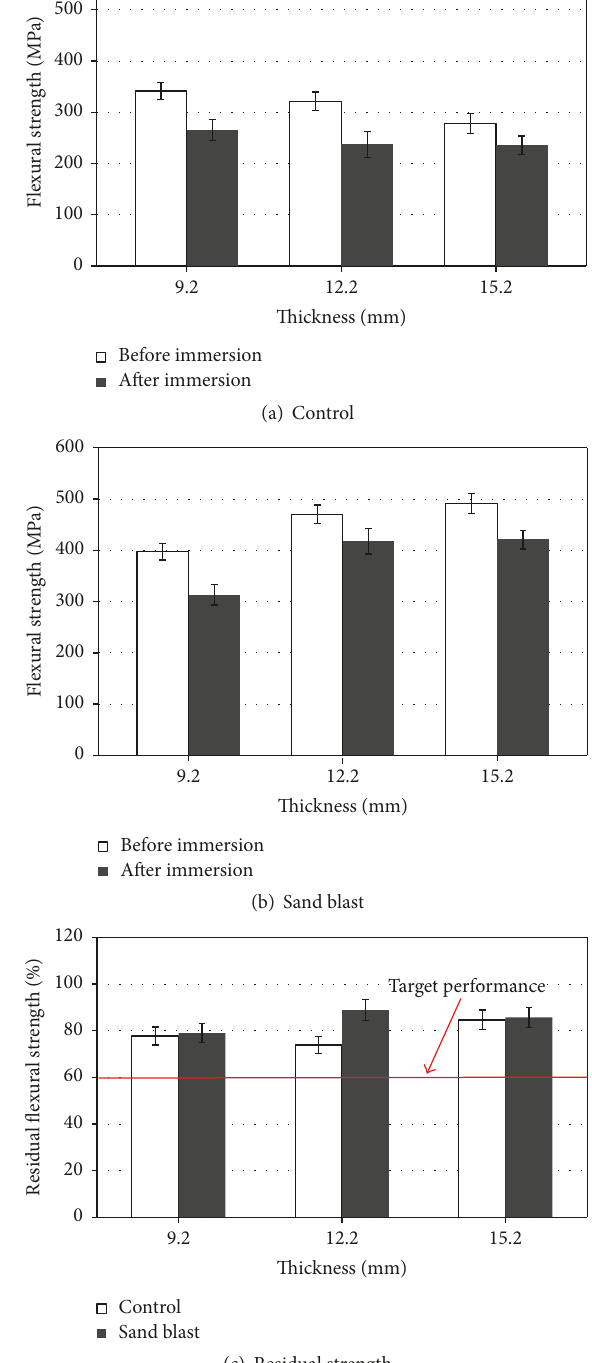
70.29%, 76.83%, and 63.44%, whilst the corresponding results upon surface sand blast processing were 78.29%, 82.20%, and 78.94%, respectively. The test results upon exposure to MgSO 4 solution are shown in Figure 15. At hybrid panel